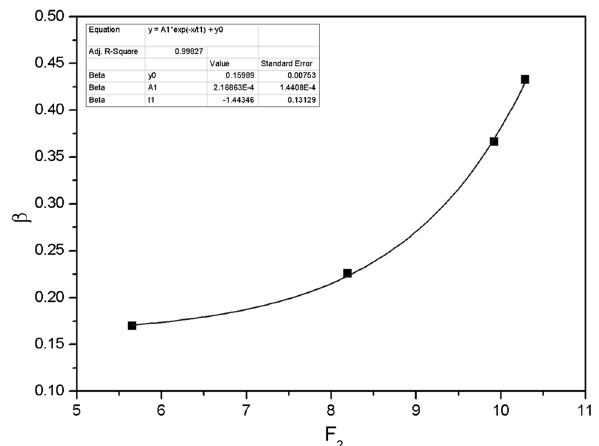
Fig. 5 Variations of the air entrainment rate with Froude